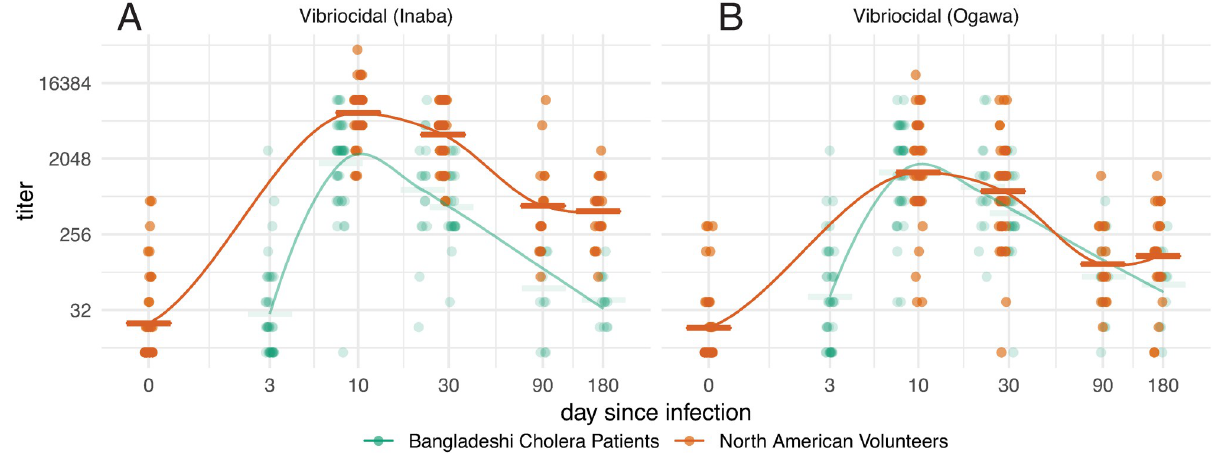
Fig 3. Vibriocidal responses over time in North American volunteers (orange) and Bangladeshi cholera patients (green). Dots represent individual responses at each time since infection (jittered) for vibriocidal titers to Inaba (A) and Ogawa (B) serotypes. Initial data points for Bangladeshi samples assigned day 3 from presumed date of infection. Lines represent LOESS curve fit to response data from each group and horizontal bars represent the geometric mean titer for each time point. Please refer to Supplemental S5 Fig for detailed statistical comparisons among values.